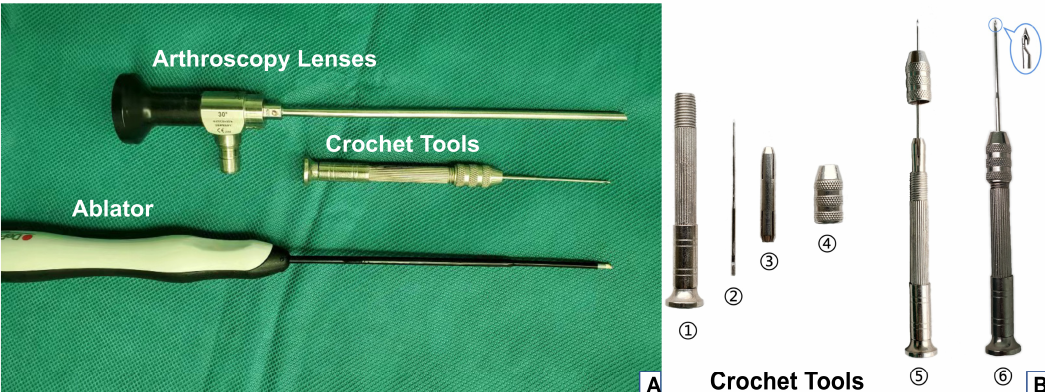
Figure 1. ( A ) Operative instrument. ( B ) An overview of crochet tool’s composition and local details: ( ① ) hollow handle, ( ② ) crochet hook, ( ③ ) tongs, ( ④ ) tightening nut, ( ⑤ ) crochet hook assembly diagram, ( ⑥ ) enlarged view of the crochet hook head end.